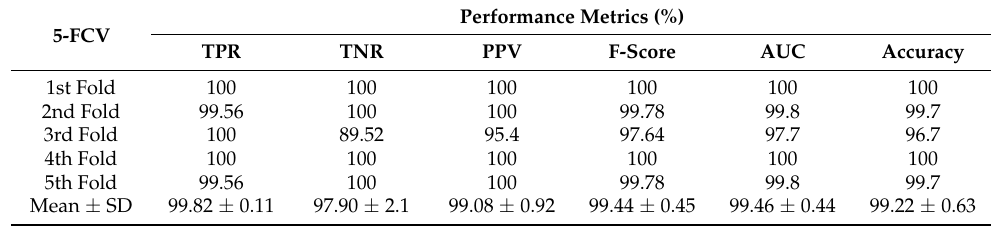
Table 8. Classification performance of the proposed model on Nadam optimizer.